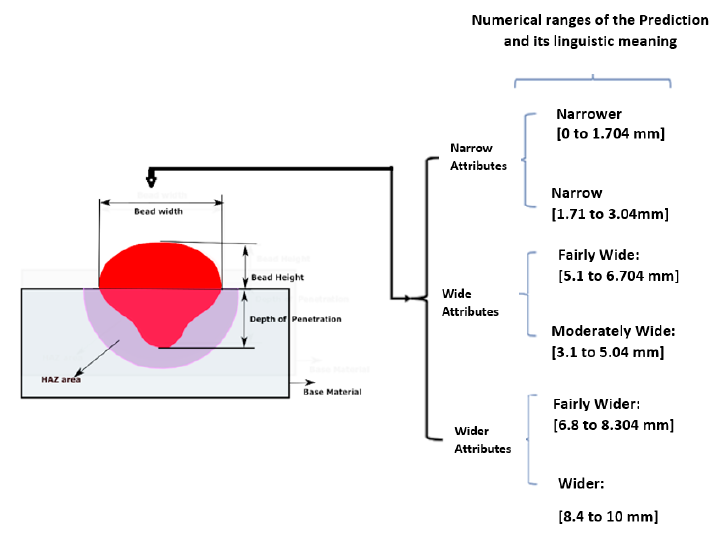
Figure 7. Number of output nodes of the model: 3 classes with 6 sub-classes.